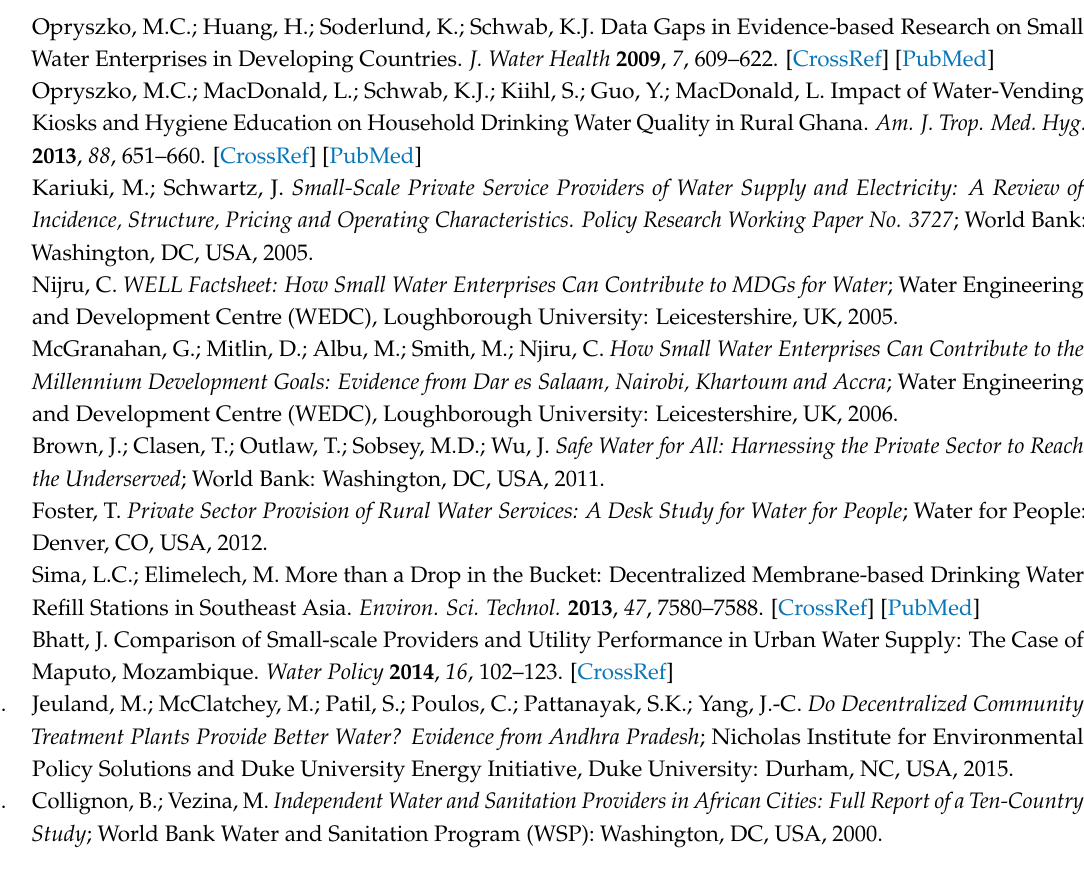
Figure S1: Estimated Demand for Treated Water from HCF kiosk and Influencing Factors, Table S1: Estimated Demand Calculation and